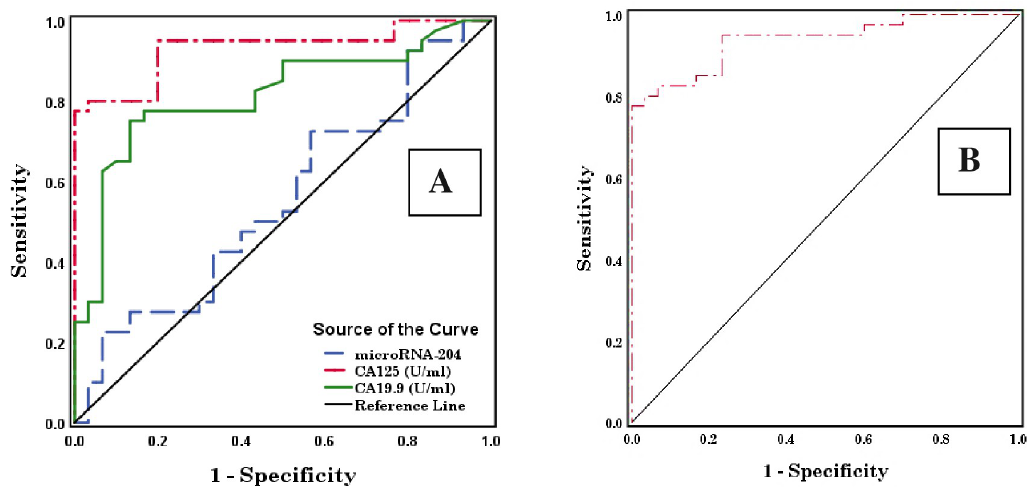
Fig 1. Receiver operating characteristic (ROC) curves of microRNA-204, CA125, and CA19.9 (A) and combined microRNA- 204, CA125, and CA19.9 (B) in benign ovarian tumor. https://doi.org/10.1371/journal.pone.0272308.g001 ROC curves describing the diagnostic performances of hepcidin, MAGP2, and FPN1 for the benign, early, and late cancer groups are shown in (Table 6 and Fig 4). For patients with benign ovarian tumors, hepcidin showed a moderate diagnostic performance with an AUC of 0.323 (p < 0.05) and a cut-off value of 203.00. The diagnostic performances of MAGP2 and FPN1 in patients with benign tumors were moderate with AUCs of 0.312 and 0.109, respec- tively (p < 0.001) and cut-off values of 12.30 and 106.40, respectively. In early ovarian cancer, hepcidin, MAGP2, and FPN1 showed weak diagnostic performances with AUCs of 0.000, 0.247, and 0.003, respectively (p < 0.001) and cut-off values of 58.00, 28.30, and 16.30, respec- tively. In late ovarian cancer, hepcidin, MAGP2, and FPN1 showed weak diagnostic perfor- mances with AUCs of 0.000, 0.128, and 0.033, respectively (p < 0.001) and cut-off values of 74.00, 22.80, and 21.40, respectively. The ROC curves describing the diagnostic performance of microRNA-204, CA125, and CA19.9 are presented in Table 7. The sensitivities of microRNA-204, CA125, and CA19.9 were extremely high at 98.04%, 100.00%, and 96.19%, and the specificities were 58.33%, 62.50%, and 57.78%, respectively. The positive predictivities (the ability of the test to correctly predict